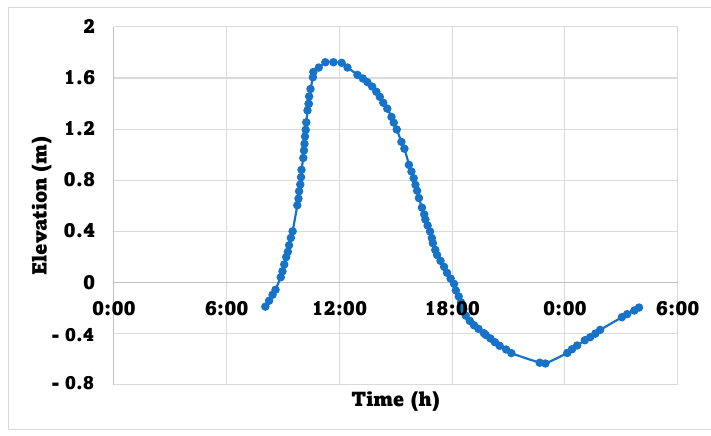
Figure 3. Water level elevation in the Rural Channel .